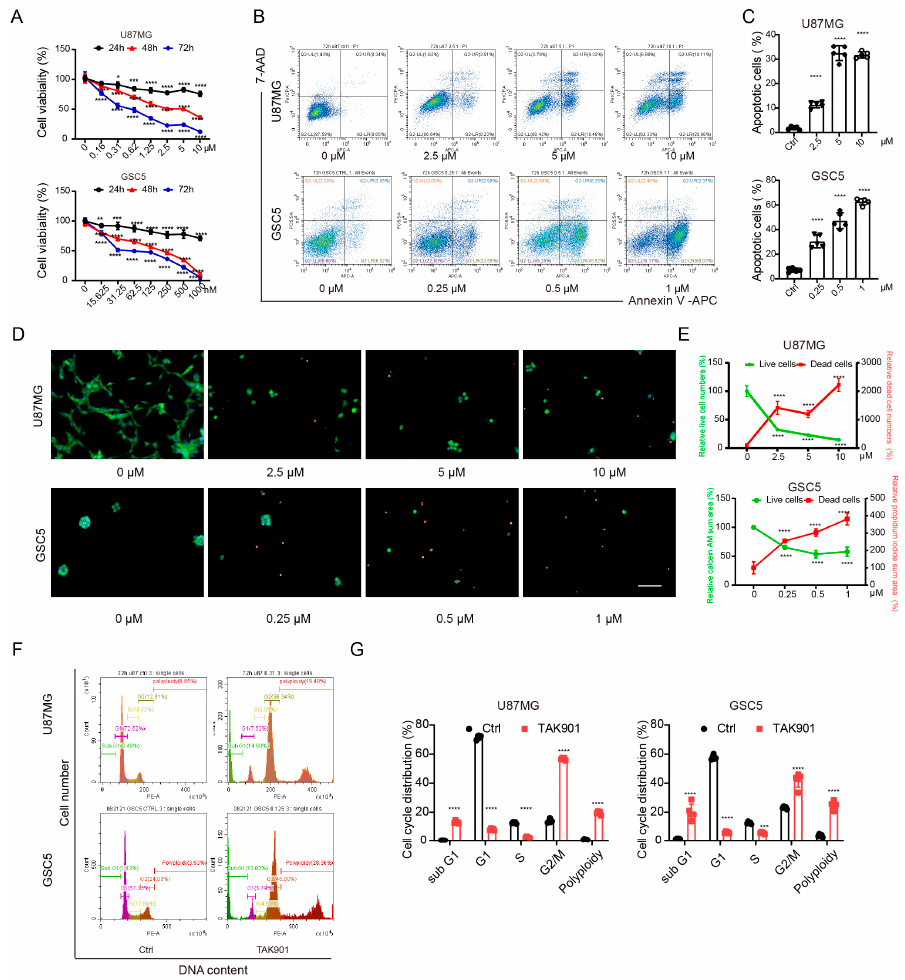
Figure 1. TAK901 inhibits the proliferation of glioblastoma (GBM) cells and causes cell cycle arrest and polyploid. ( A ) U87MG and GSC5 cells were treated with increasing concentrations of TAK901 for 24 h, 48 h and 72 h. The cell viability was analyzed. CellTiter-Glo assays were performed in triplicate, and representative results are shown ( n = 5). ( B ) U87MG and GSC5 cells were treated with increasing concentrations of TAK901 for 72 h. The cells were subjected to Annexin V and 7-AAD staining and analyzed by flow cytometry. ( C ) Quantification of the total apoptotic cells ( n = 5). ( D ) U87MG and GSC5 cells were treated with the indicated concentrations of TAK901 for 72 h. Calcein- AM and propidium iodine were used to identify live and dead cells, respectively. The images were captured by Operetta high content screening. Scale bar, 100 μ m. ( E ) Quantification of live and dead cells in U87MG and GSC5 ( n = 5). ( F ) Cell cycle assays through PI staining. U87MG and GSC5 cells were treated with low concentration of TAK901 for 72 h. ( G ) Quantification of the cell cycle assays in U87MG and GSC5 ( n = 5). Significance was determined by one-way ANOVA with Dunnett’s multiple comparison adjustment ( A , C , E ) or unpaired and two-tailed Student’s t -test ( G ). * p < 0.05, ** p < 0.001, *** p < 0.001, **** p < 0.0001. 3.2. TAK901 Suppresses the Migration, Invasion, and Stemness of GBM Cells Tumor invasiveness, therapeutic resistance, and recurrence are highly associated with poor prognosis of patients with GBM. Therefore, we investigated the effect of TAK901 on the migration, invasion, and stemness of GBM cells. The Transwell assay showed that the TAK901-treated group had fewer cells migrating through the chambers, indicating that the migration and invasion ability of U87MG was impaired after treatment with TAK901 (Figure 2A,B). To validate this result, we performed a 3D Matrigel invasion